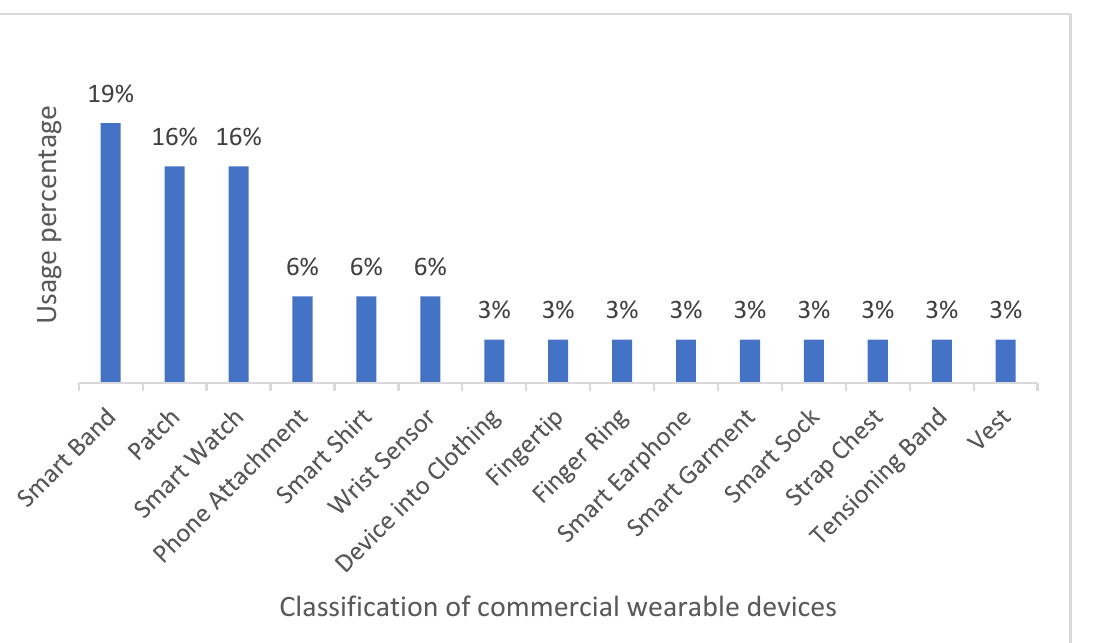
Figure 3. Classification of commercial wearable devices.